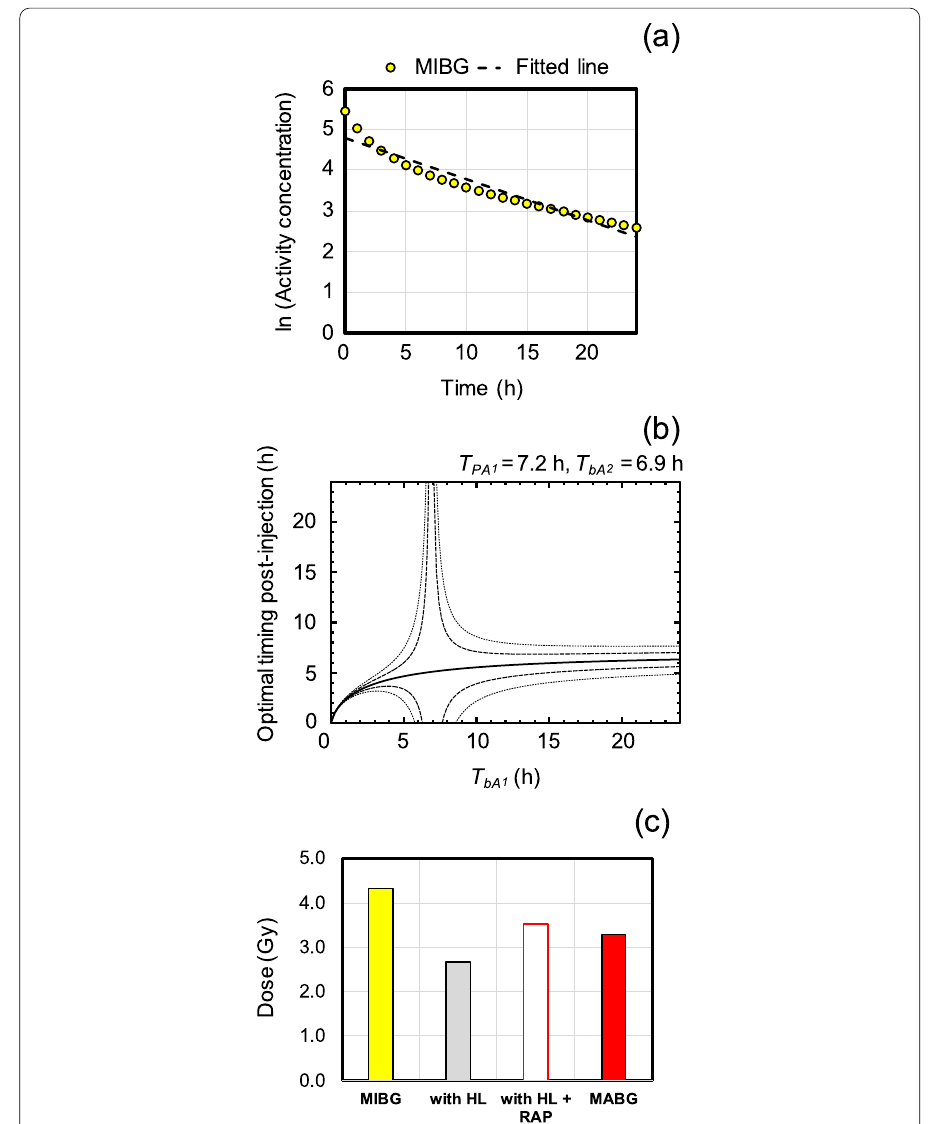
Fig. 6 Sample of a RAP dose conversion using an optimal timing behavior map for a single biodistribution measurement (%ID/g) on 211 At-labeled target compounds. First, a plotted values converted to logarithms of [ 131 I]MIBG [8] corrected by the physical half-life of 131 I, i.e., a biological component, and fitted by the linear function (the dashed line). Second, b draws the behavior map of an optimal timing (solid line) on a target compound with a physical HL of 7.2 h and a reference with a 6.9 h HL of biological clearance, T bA 2 , which was derived from the fitting curve on panel ( a ). The dashed and dotted lines represent optimal timing in the cases of 0.95 and 1.05, and 0.9 and 1.1 times converted absorbed doses, respectively. Finally, c converted absorbed doses of [ 131 I]MIBG [8], “with HL,” “with HL RAP,” and a true target absorbed dose of [ 211 At]MABG +